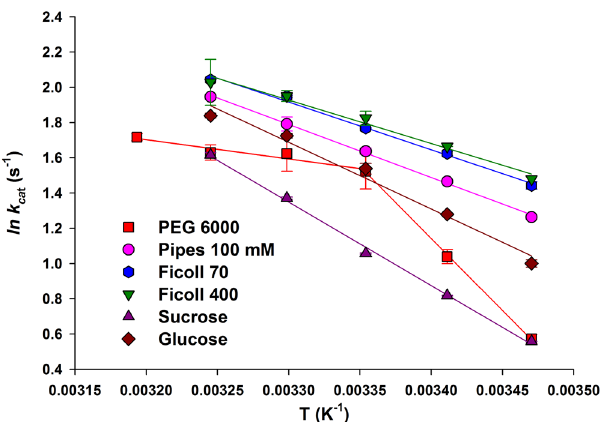
Figure 3. Arrhenius plot for different crowding agents (temperature dependence of ln k cat ). Saturating NADH (200 µ M) and DD-CoA (105 µ M) concentrations and 200 mg mL − 1 of crowding agents were used to determine the maximum velocity as a function of temperature ranging from 15 to 35 °C for crowding agents, except for PEG 6000 (15 to 40